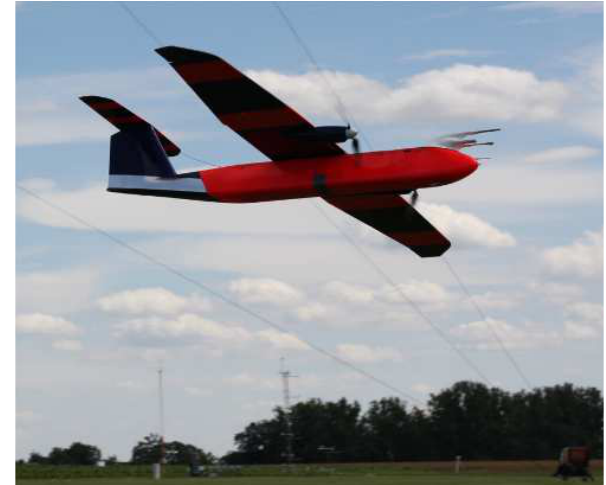
Fig. 1. The M 2 AV flying near the Meteorological Observatory Lindenberg – Richard-Aßmann-Observatory during the LITFASS- 2009